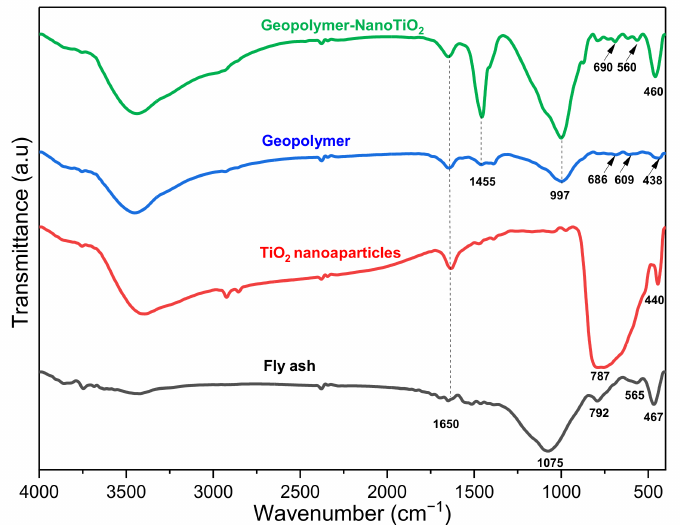
Figure 2. FTIR spectra of fly ash, TiO 2 nanoparticles, geopolymer and geopolymer-NanoTiO 2